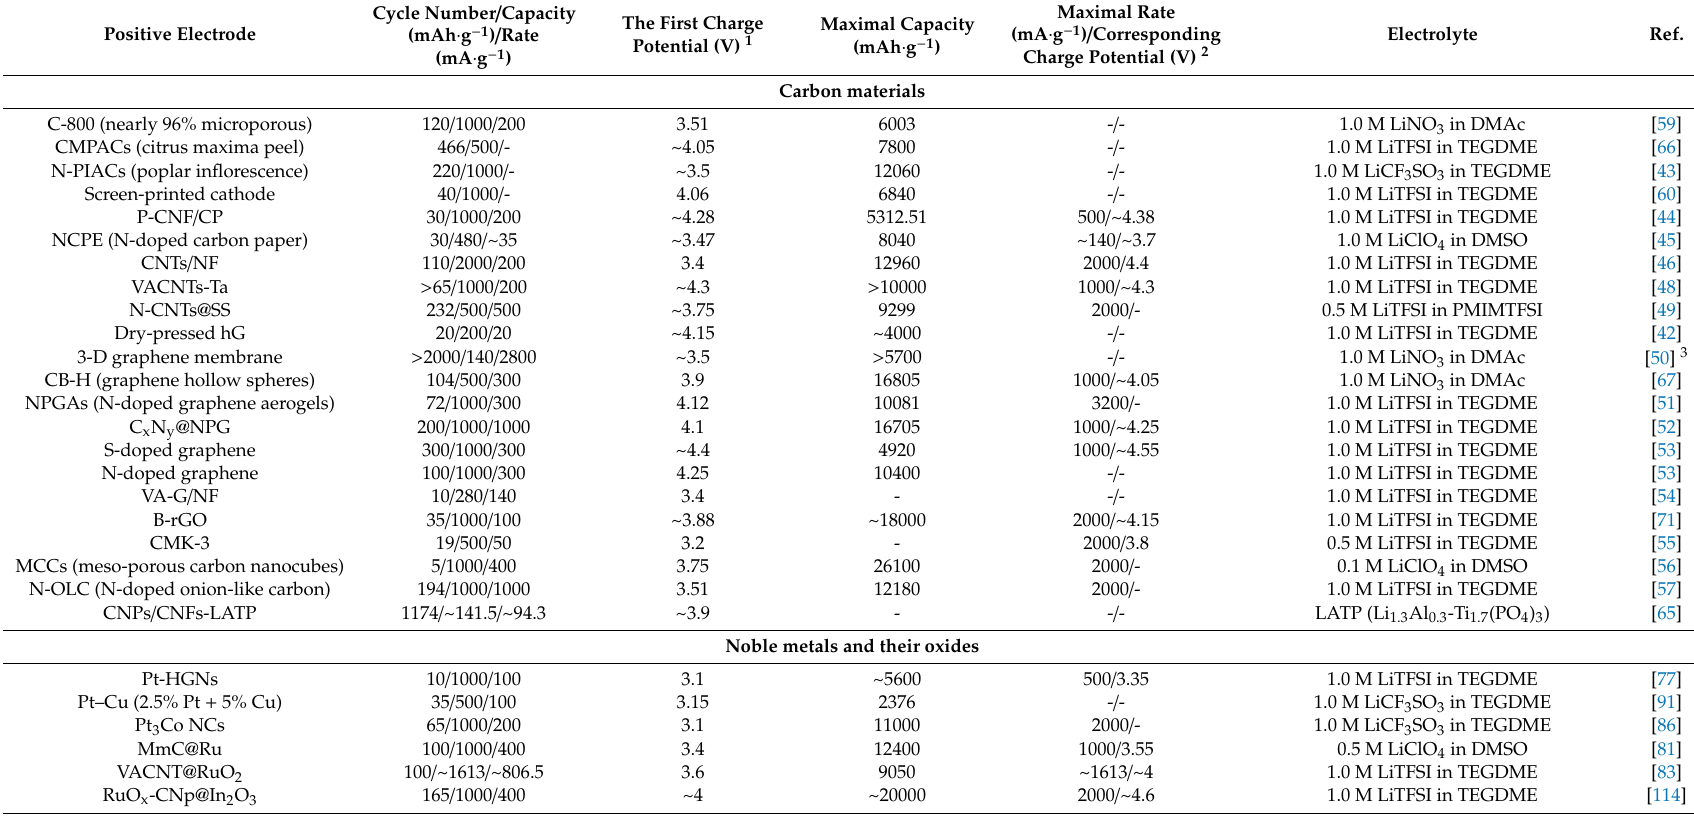
Table 1. A summary on electrochemical performance of Li-O 2 batteries with di ff erent positive electrode materials. Positive